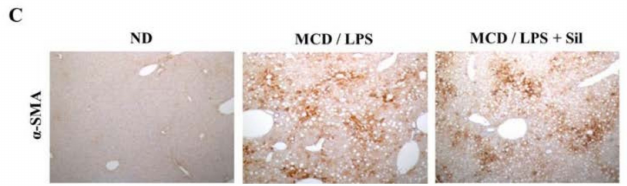
Figure 1. Effect of silibinin on hepatocellular injury. Mice were fed ND, MCD/LPS diet, or MCD/LPS diet + silibinin for three weeks. ( A ) The histology of the liver sections from these three groups was assessed by hematoxylin-eosin (H&E) staining (original magnification, 200 × ). ( B ) Serum AST, ALT values and the expression levels of the proteins involved in the development of steatohepatitis, such as TGF β 1 , TNF- α , IL6 , and iNOS , were measured by qRT-PCR. Genes were normalized to GAPDH RNA as an internal standard. Fold-increase data are expressed. Data are the mean ± SD ( n = 7/group). * p < 0.05 vs. ND group, and # p < 0.05 vs. MCD/LPS group. ( C ) Liver sections of the mice fed ND, MCD/LPS, or MCD/LPS + silibinin were subjected to immunohistochemical analysis for α -SMA (original magnification, 100 × ).